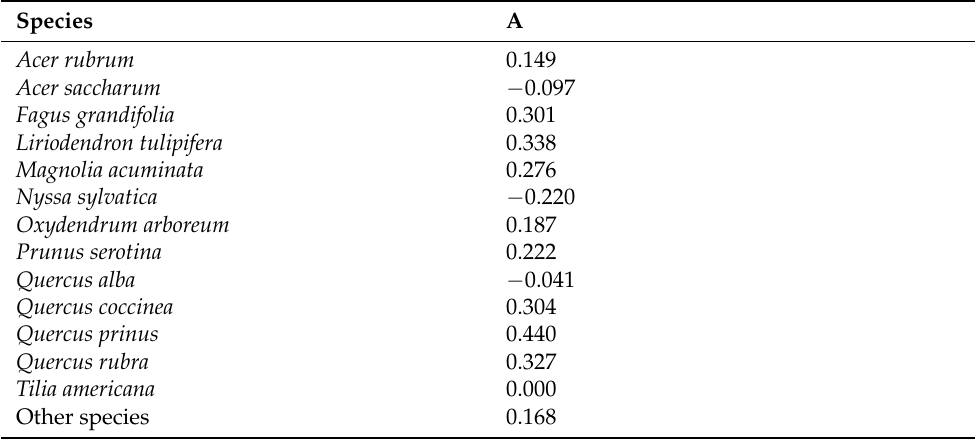
Table A1. Species-specific constants ( α ) used in woody N storage